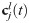
A high-level description of the expert and its inputs/outputs.The observations are converted by the Spatial Pooler into a one-hot vector x(t) representing cluster center probabilities. The Temporal Pooler computes probabilities of known sequences P(S)(t), which are then projected to the output. The external context cjl(t) is received from top-down and lateral connections from other Experts. The corresponding goal vector gjl(t) is used to define a high-level description of the goal state. The Context output of the Expert typically conveys the current cluster center probabilities, while the Goal output represents a (potentially actively chosen) preference for the next state expressed as expected rewards. This can be interpreted as a goal in the lower levels or used directly by the environment (see Appendix S8 Goal-directed Inference).